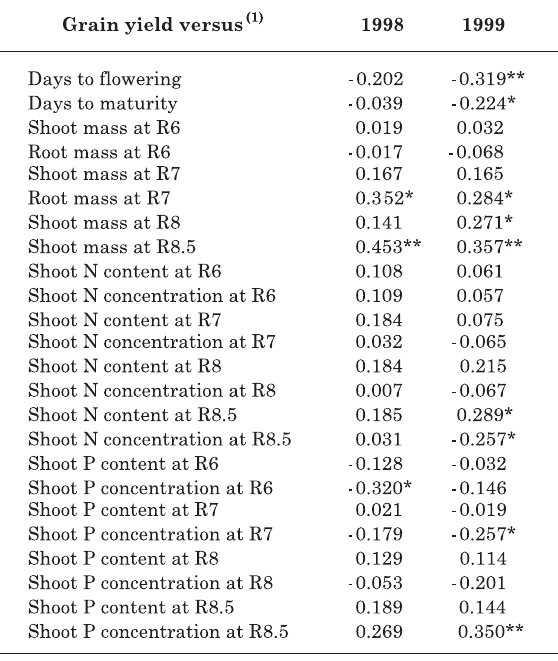
Table 4. Coefficients of simple correlation between grain yield and traits related to biomass and nutrient accumulation of common bean cultivars grown in two field experiments (1998